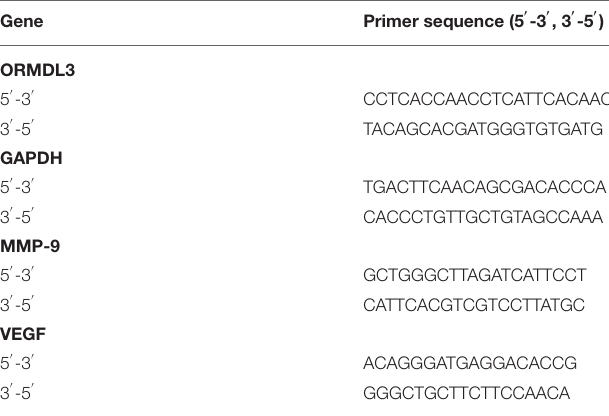
TABLE 1 | The primers used to detect ORMDL3, GAPDH, MMP9, and VEGF